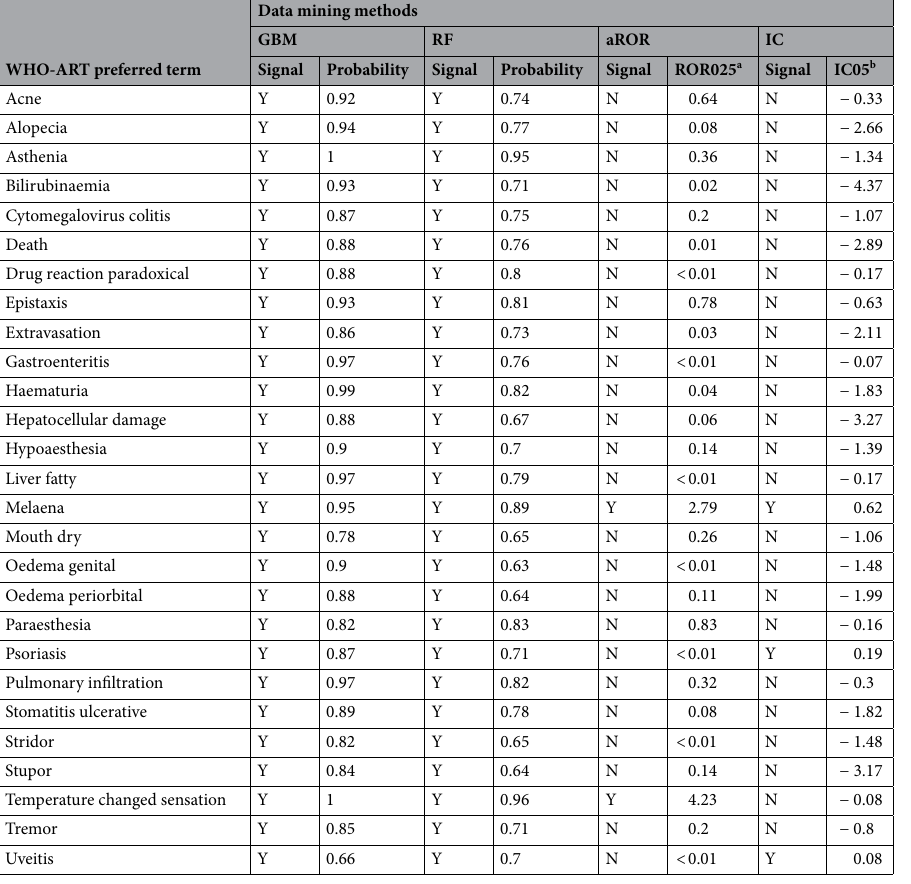
Table 3. Safety signal detection among the unknown AEs of infliximab reported in the KAERS between 2009 and 2018. KAERS Korea Adverse Event Reporting System, WHO-ART world health organization−adverse reaction terminology, RF random forest, GBM gradient boosting machine, aROR adjusted reporting odds ratio, IC information component. a Lower bound of the 95% confidence interval of adjusted ROR. b Lower bound of the 90% confidence interval of